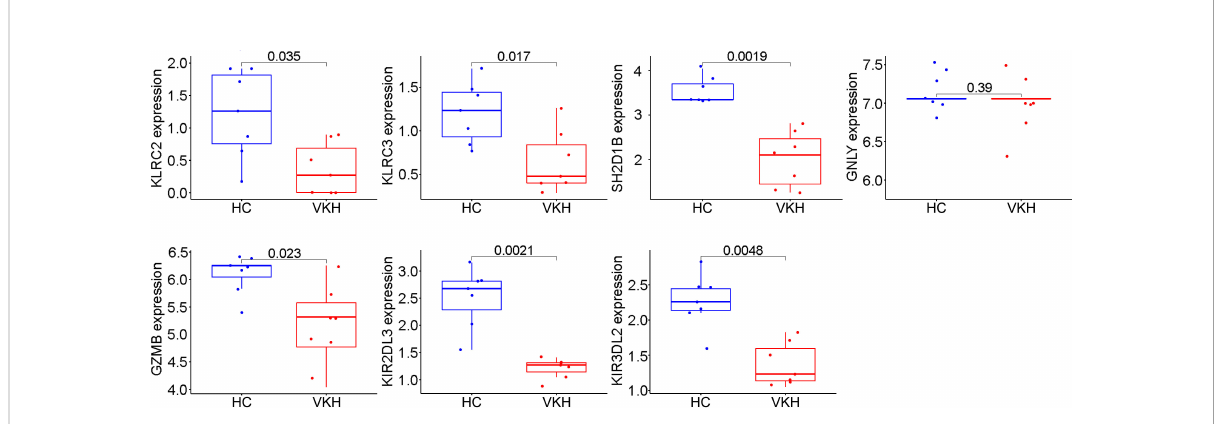
FIGURE 5 Validation of immune potential hub genes in the gene expression level. The expressions of KLRC2, KLRC3, SH2D1B, GZMB, KIR2DL3, and KIR3DL2 were signi fi cantly lower in Vogt-Koyanagi-Harada patients (VKH) than in healthy controls (HC). The expression level of GNLY was not statistically signi fi cantly different between the two groups.